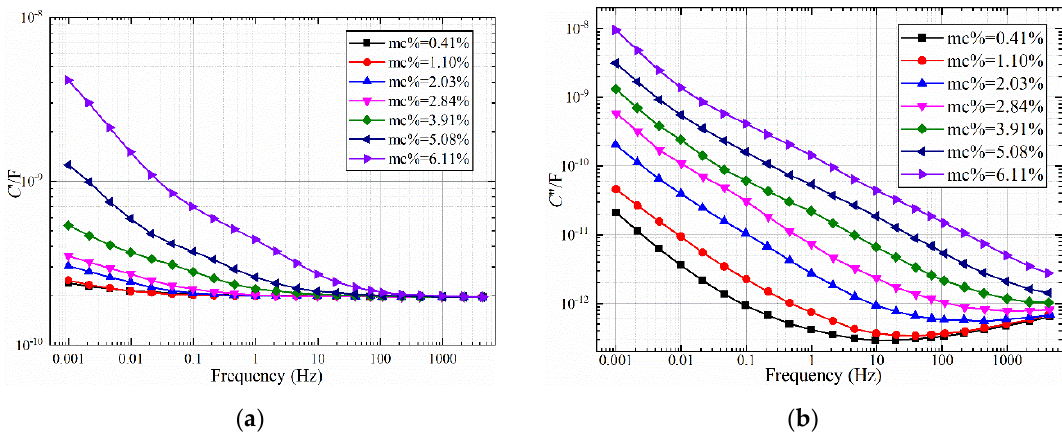
Figure 5. C *- f curves with different moisture contents. ( a ) C ′- f , ( b ) C ″- f .